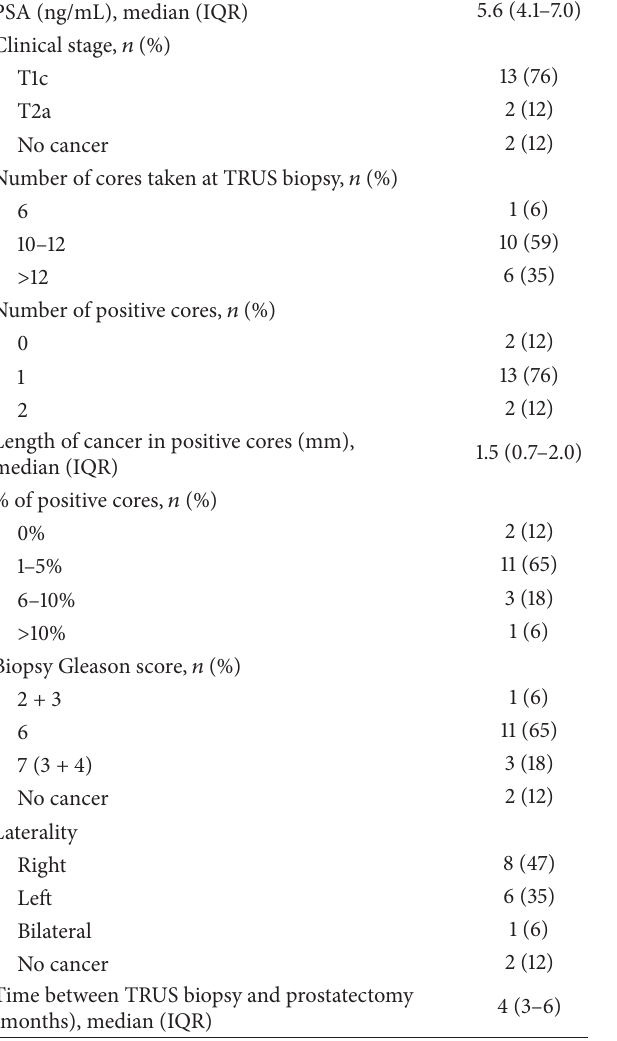
Table 2: Overall characteristics of TMB and prostatectomy speci- mens ( 𝑁 = 17